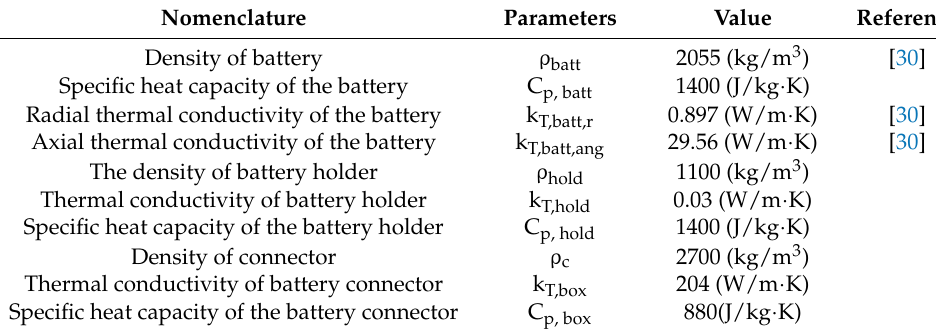
Table 2. Thermo-physical parameters of materials used in the simulation.